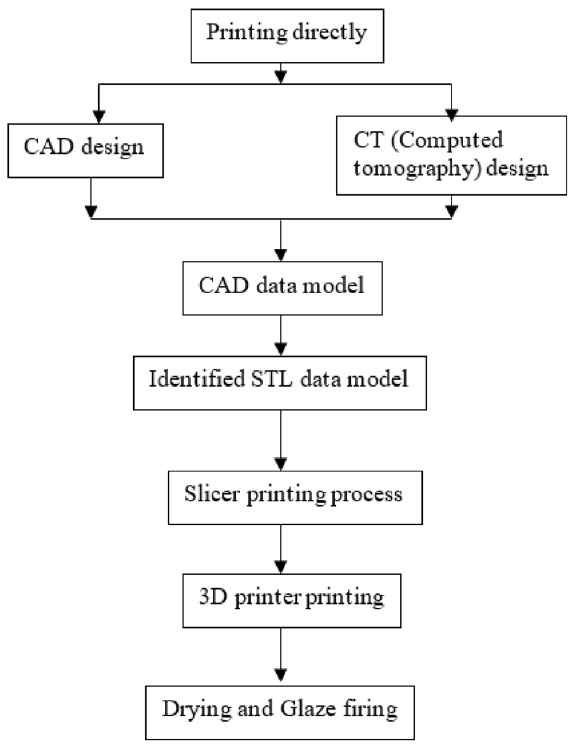
Fig. 1 Flowchart of the 3D process of ceramic manufacture by slip